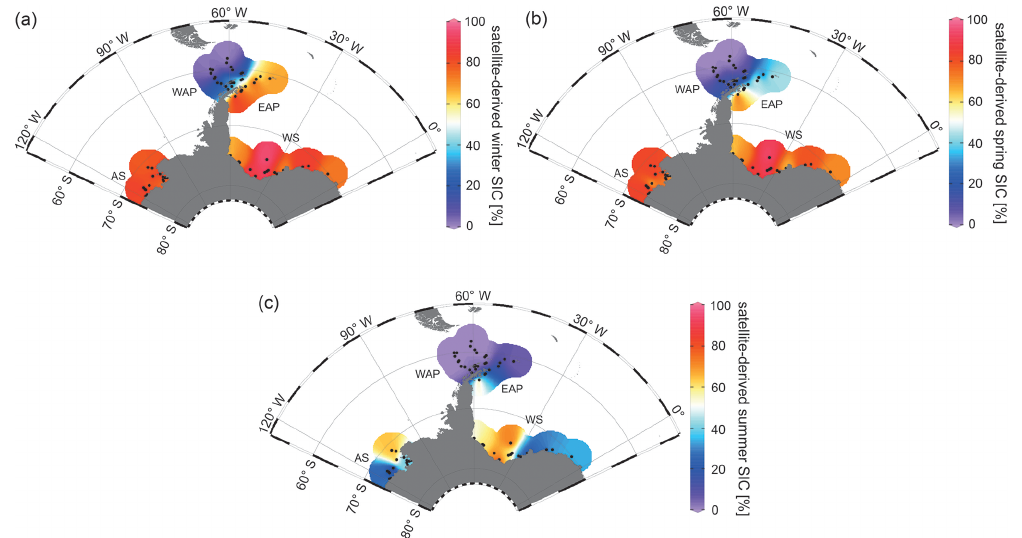
Figure 2. Distribution of mean monthly satellite-derived sea-ice concentration (SIC) for (a) winter (JJA), (b) spring (SON) and (c) summer (DJF) in percent (downloaded from the National Snow and Ice Data Center, NSIDC; Cavalieri et al., 1996). The following abbreviations are used in the figure: AS – Amundsen Sea, WAP – West Antarctic Peninsula, EAP – East Antarctic Peninsula and WS – Weddell Sea. Maps were generated using the Ocean Data View Software (ODV; Schlitzer,